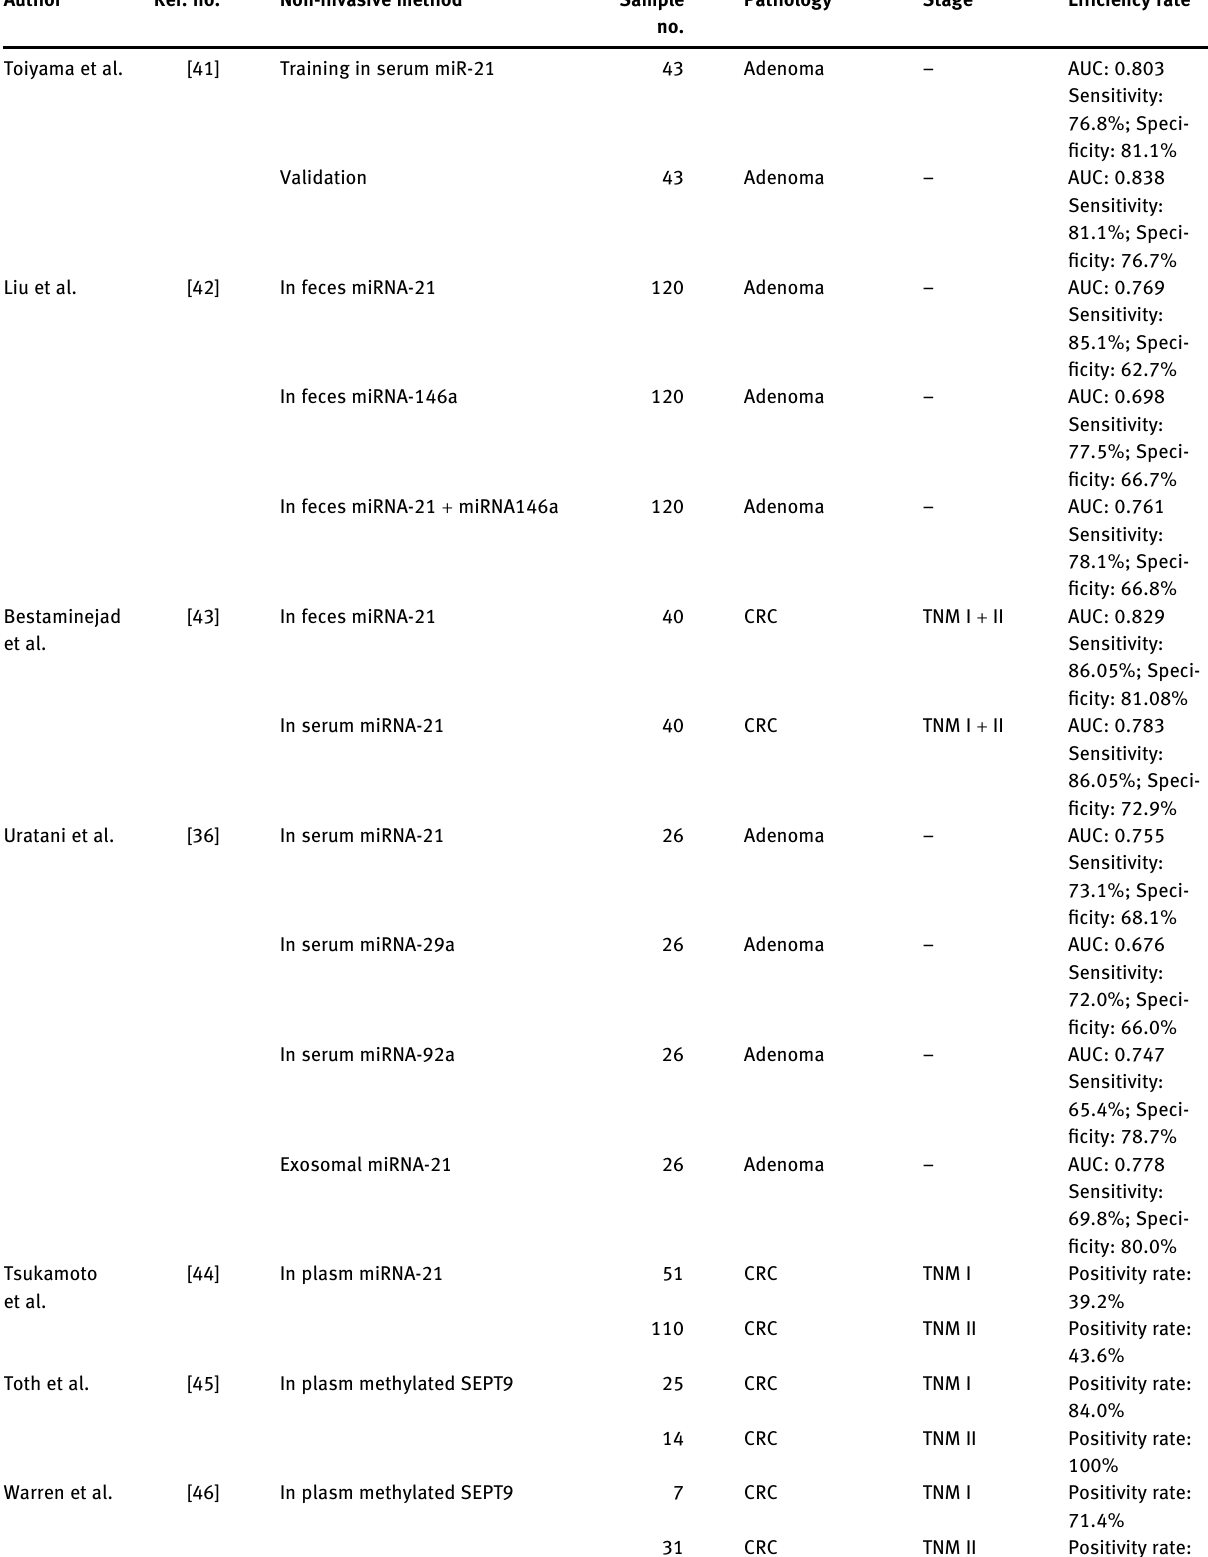
Table  : Ef fi cacy rates in diagnostic studies conducted in recent years in noninvasive MMs, precancerous lesions and early-stage CRCs.